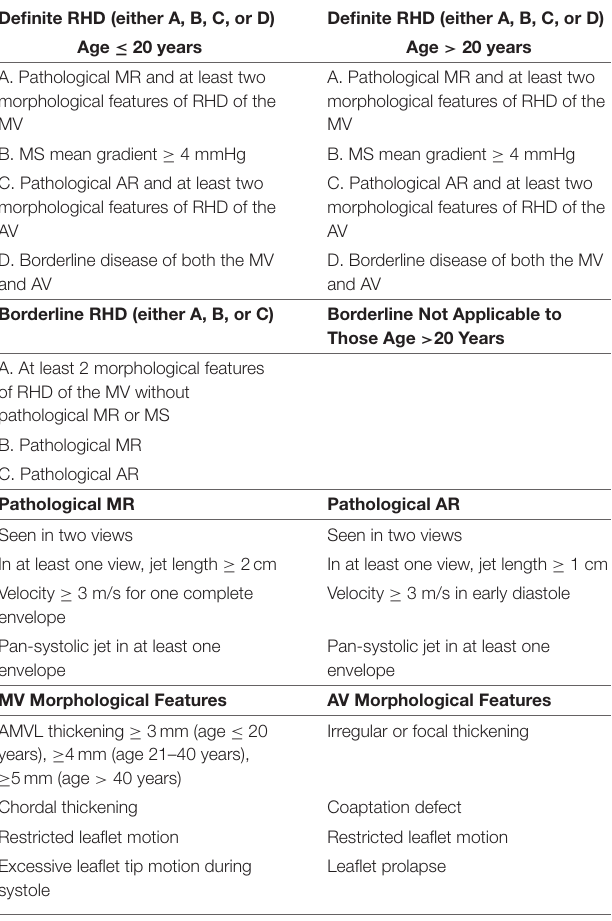
TABLE 2 | Simplified echocardiography scoring system